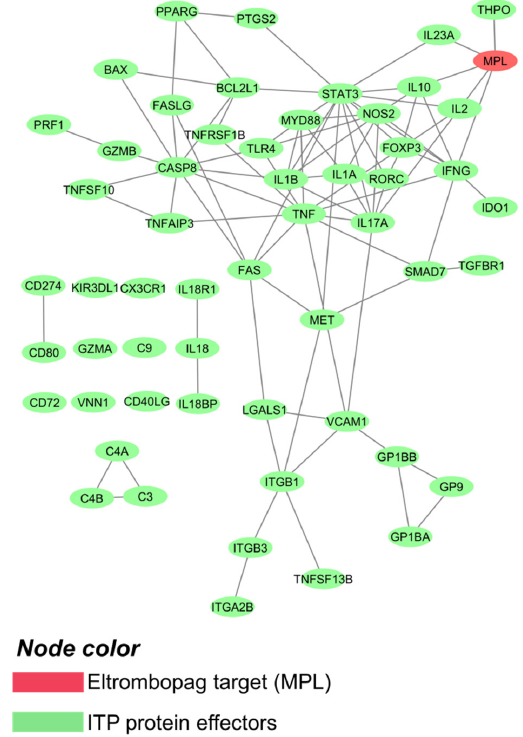
Figure 1. ITP interactome, focusing on drug targets and disease main players. Image created with Cytoscape3.6 [46].